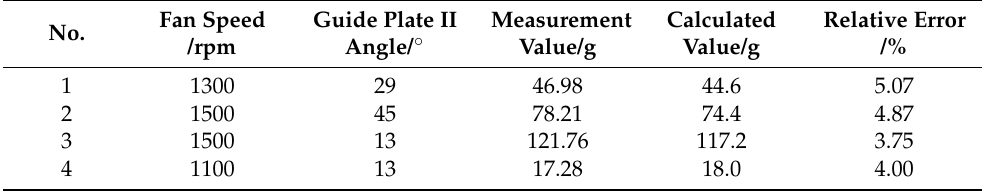
Table 6. Relative error between theoretical and practical values in the sensor monitoring area.